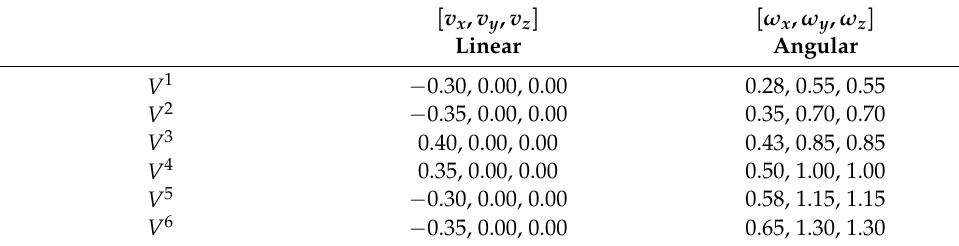
Table 2. Input linear (m/s) and angular ( ◦ /s) velocities of vehicles for all